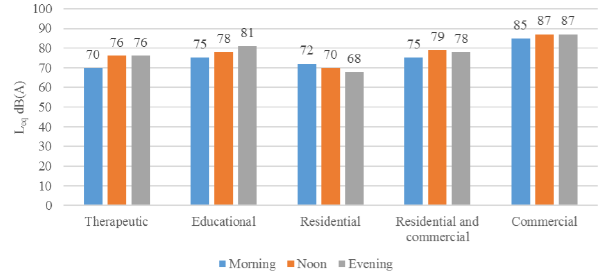
Figure 2: L eq in five uses